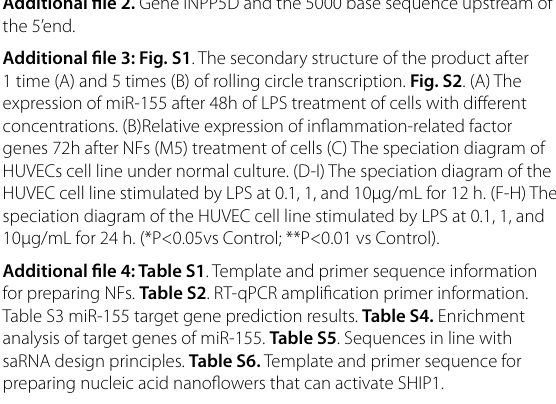
Additional file 4: Table S1 . Template and primer sequence information for preparing NFs. Table S2 . RT-qPCR amplification primer information. Table S3 miR-155 target gene prediction results. Table S4. Enrichment analysis of target genes of miR-155. Table S5 . Sequences in line